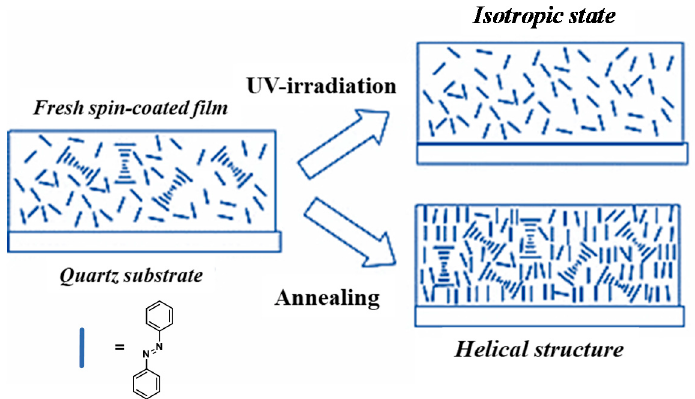
Figure 7. Idealized scheme of photoinduced and thermoinduced structural changes in the spin-coated film of the chiral Azo-polymer 11.